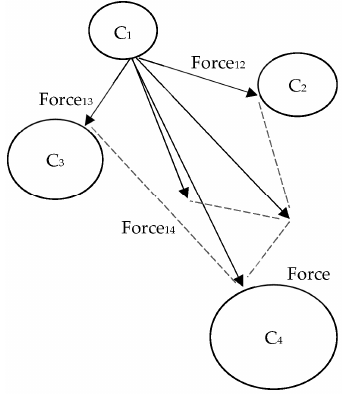
Figure 1. Illustration of the forces exerted on charges.